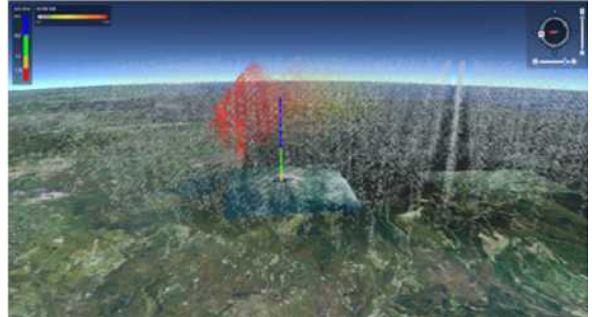
Figure 9. 3D visualization result with "Cube in the Cube"